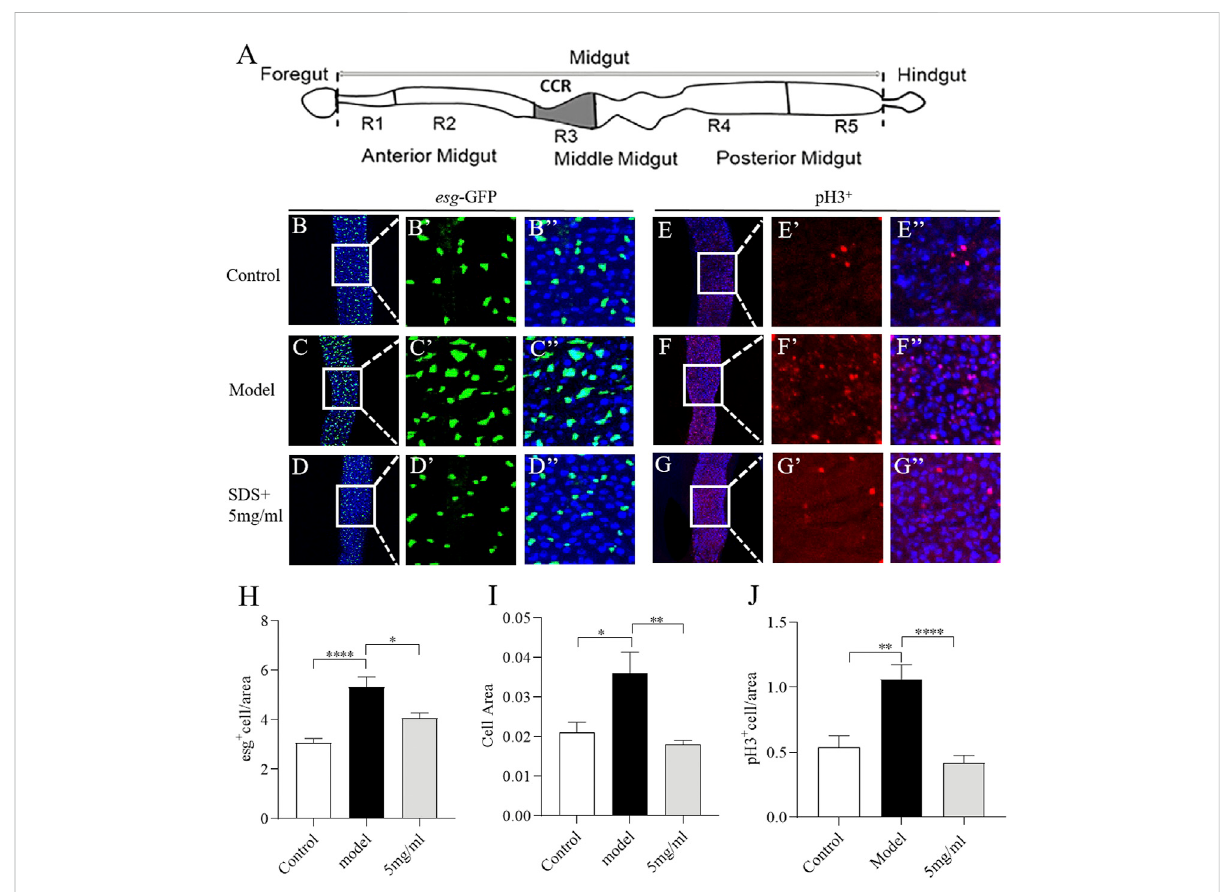
FIGURE 5 FPE protects intestinal stem cells (ISCs) from toxic chemical-induced proliferation and differentiation. (A) Schematic diagram of the fl y gut, and the dissected site for immunostaining (grey). (B – D) Immuno fl uorescence images of the dissected midguts of esg- GFP in control fl ies and 0.6% SDS stimulated fl ies fed with or without 5 mg/ml FPE. esg- GFP: ISC/enteroblast cell marker (green). Quanti fi cation of the relative size (H) and number (I) of esg positive cells ( n = 13 – 15). (E – G) Immuno fl uorescence images of the pH3 positive cells in control fl ies and 0.6% SDS stimulated fl ies fed withorwithout5 mg/mlFPE.Thegutsof fl ieswerelabeledwithanti-pH3(Red)andDAPI(blue). (J) Quanti fi cationofthenumberofpH3positivecells ( n = 11 – 13). * p < 0.05, ** p < 0.01, **** p < 0.0001 vs. the model